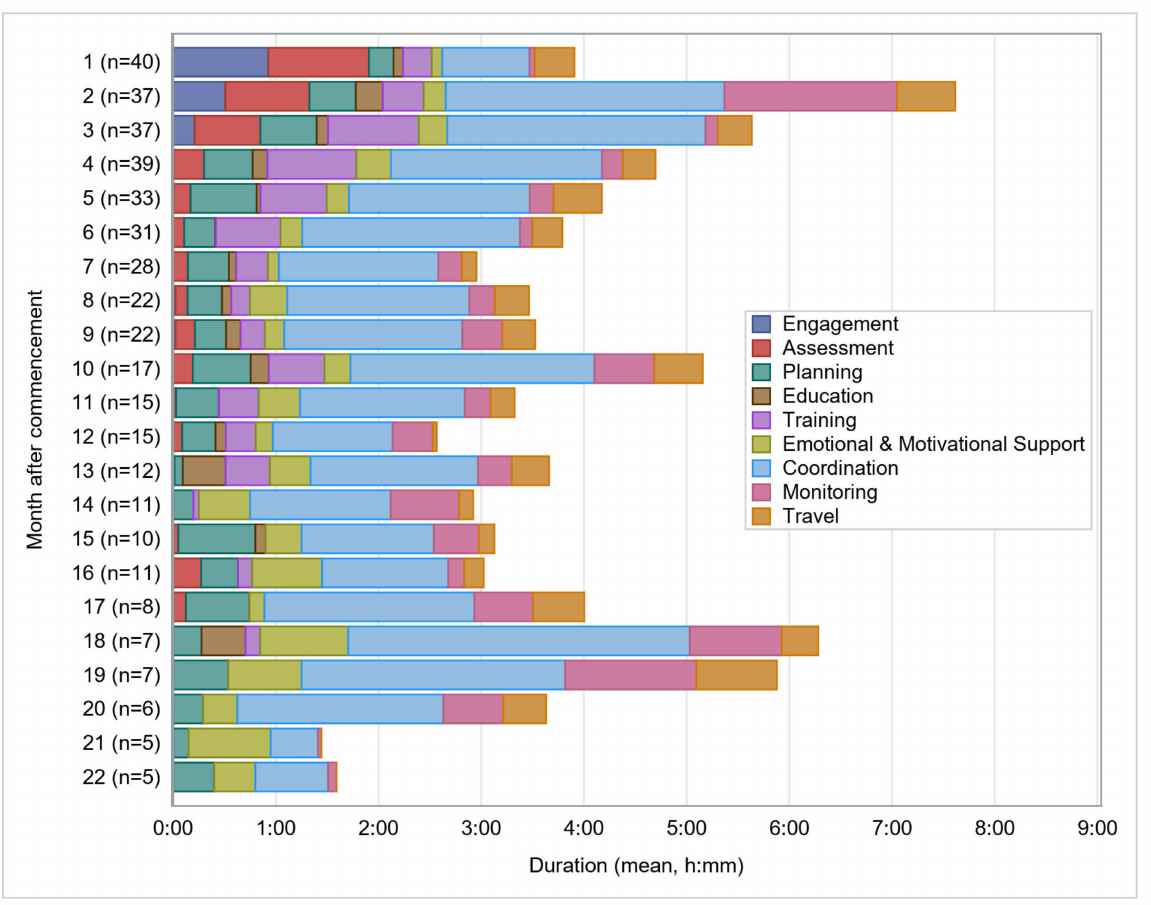
Figure 4. Service actions over time—New